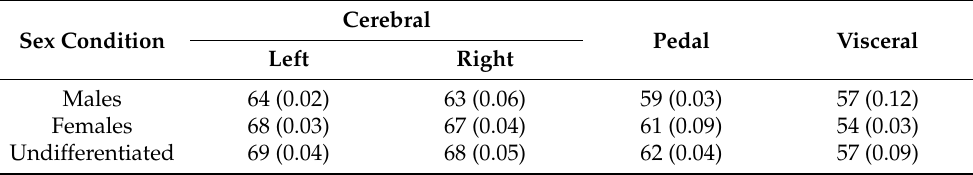
Table 3. Relative volumes (%) of the cerebral, pedal, and visceral ganglia cortex of S. plana . Sex Condition